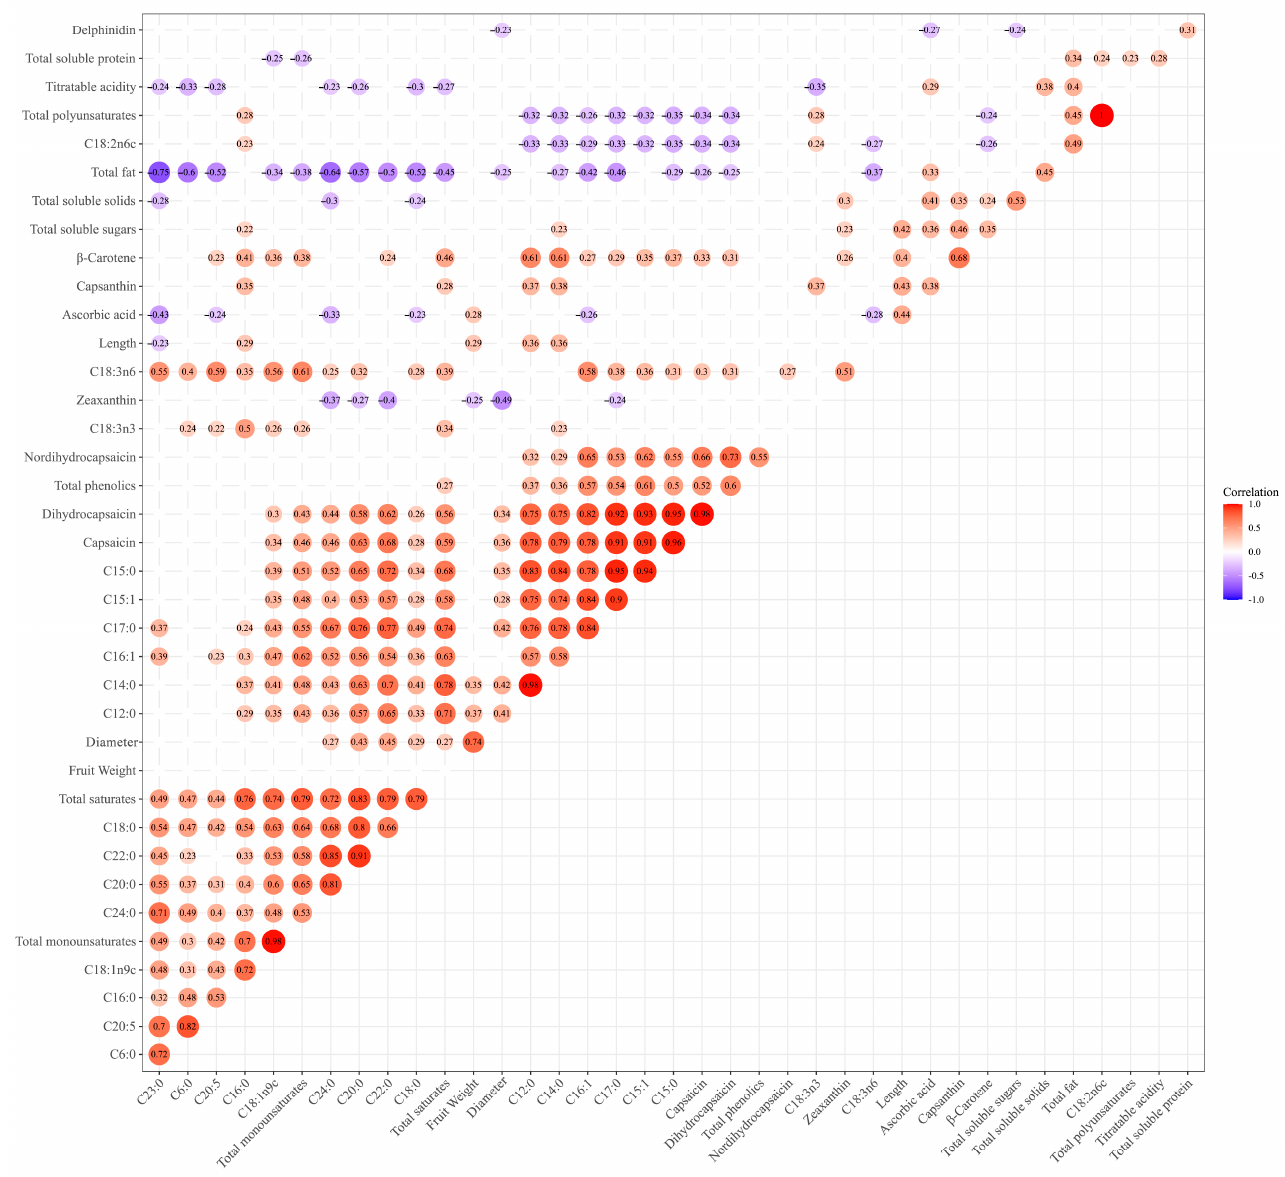
Figure 2. Correlation heat map of quality-related indicators in the 75 pepper resources. Blue means negative correlation, red means positive correlation. The depth of the color represents the level of correlation (the higher the correlation, the darker the color). The size of the circle also indicates the level of the correlation coefficient, and the higher the correlation coefficient, the larger the circle. If p value is greater than 0.05, there is no circle display.